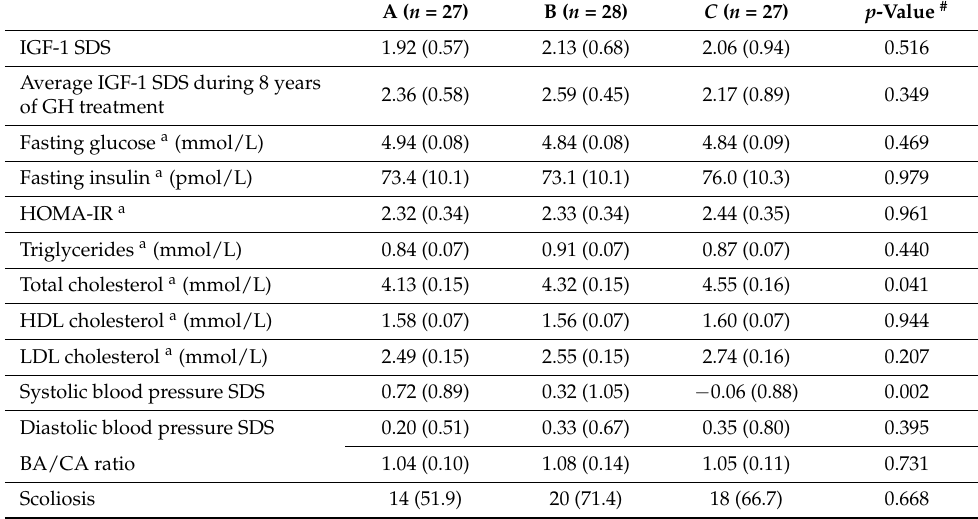
Table 4. Safety parameters after 8 years of GH treatment between the